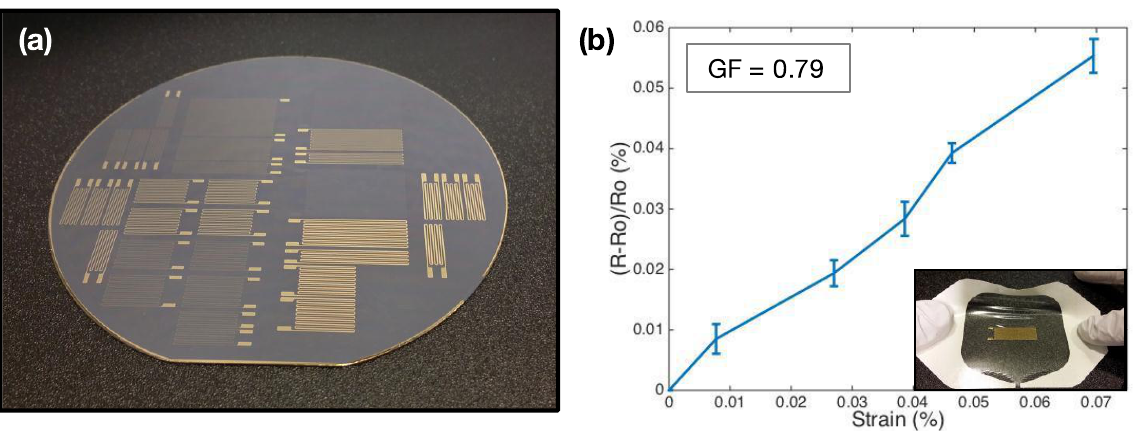
Figure 7. Mechanical strain sensor fabrication using AP process: ( a ) mechanical strain sensors on wafer; ( b ) characteristics of a simple mechanical strain sensor; and ( b , inset ) Image of AP strain sensor stretched during axial testing. Gauge factor (GF) =